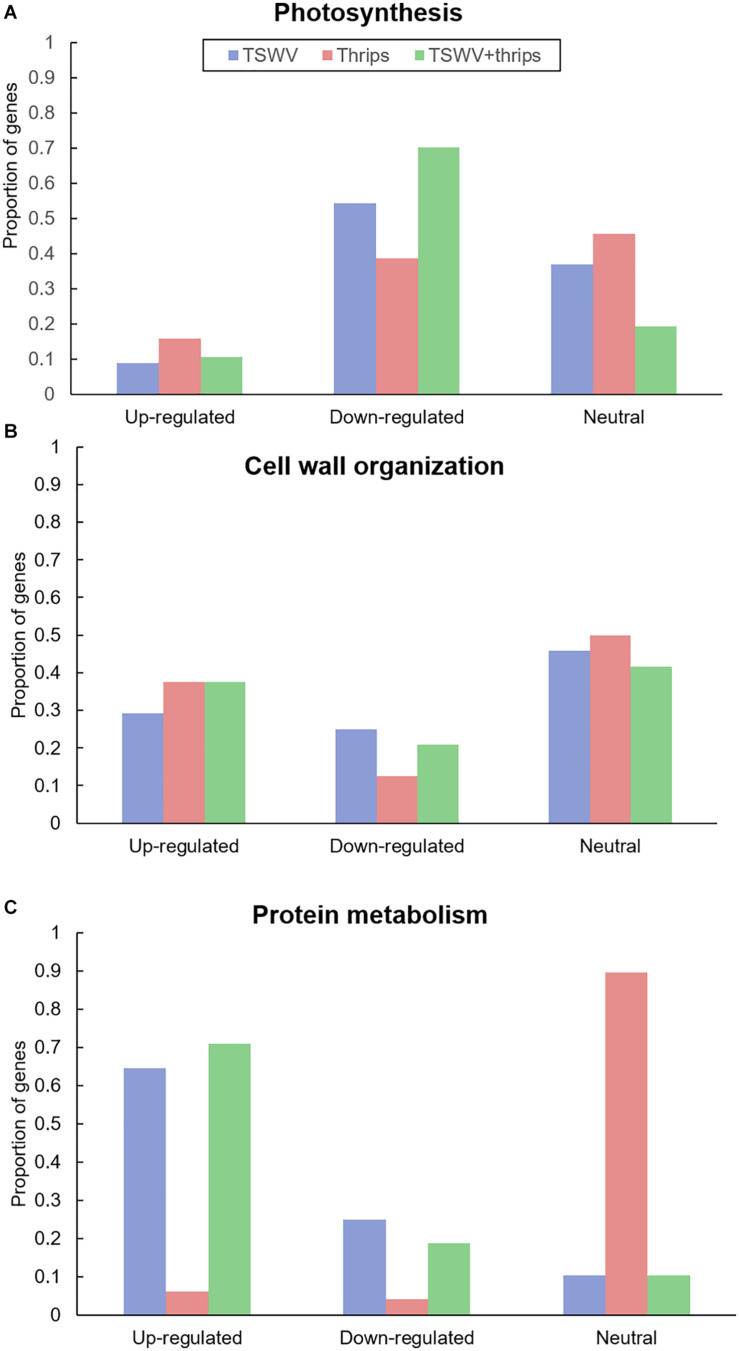
Proportion of differentially-expressed genes involved in (A) photosynthesis and (B) cell wall organization and (C) protein metabolism in response to TSWV infection alone, F. occidentalis alone, and the combined treatment. n = 57 possible photosynthesis genes, n = 24 possible cell wall related genes and n = 48 possible protein metabolism genes represented on the array. The list of these genes and the average normalized hybridization values are provided in Supplementary Table 5.